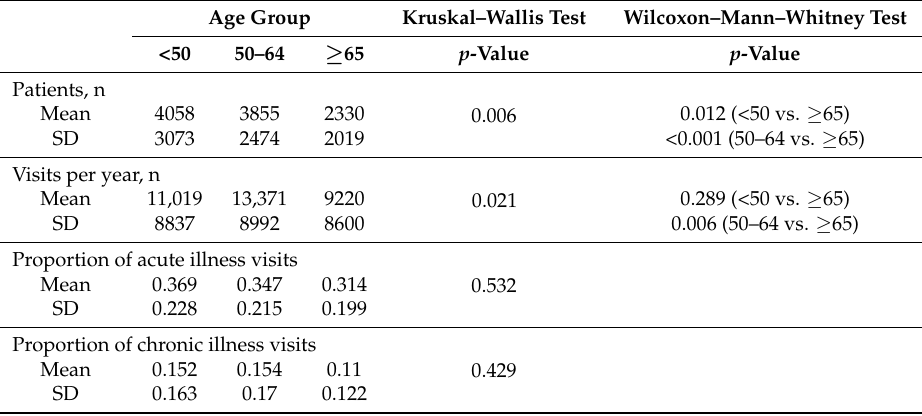
Table 2. Patients, visits and disease patterns for different age groups of family